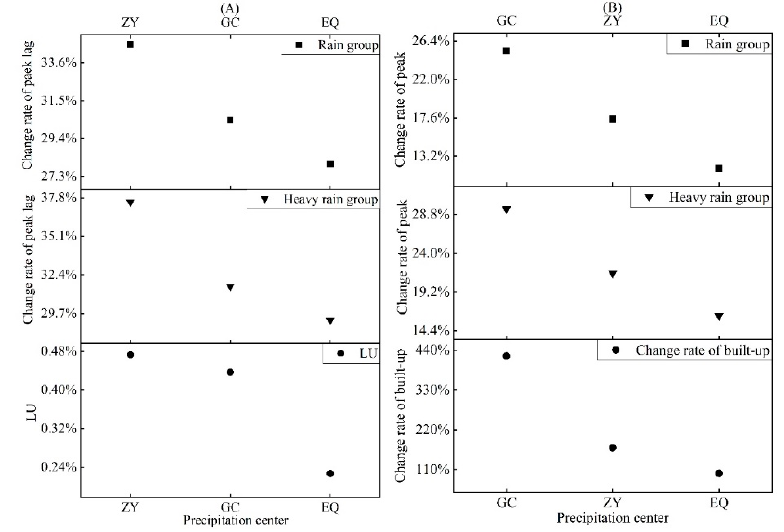
Figure 8. ( A ) Relationship between LU and change of peak lag, ( B ) relationship between built-up and change of peak.